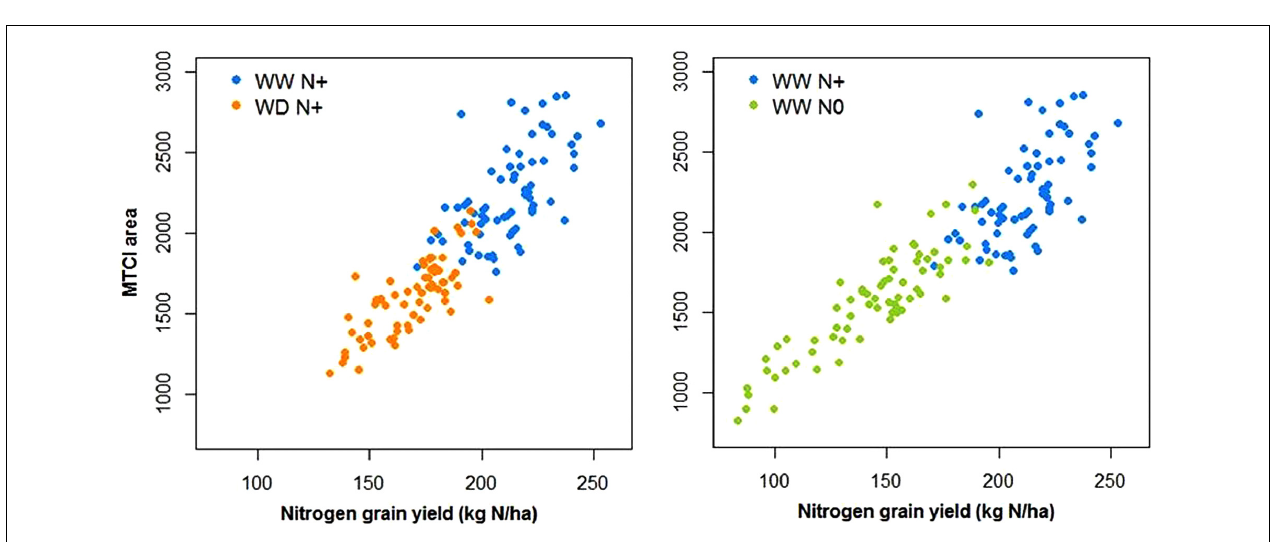
FIGURE 13 | Relationship between the N grain yield and the area under the MTCI curve between flowering and maturity under well-watered conditions with and without nitrogen input (WW N+ and WW N0) and water deficient conditions with nitrogen input (WD N+, N =